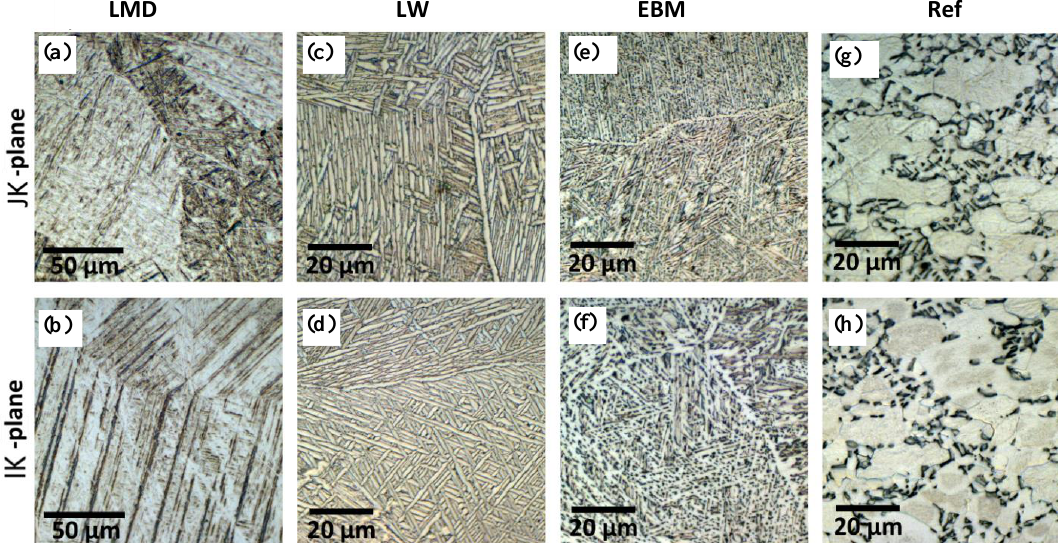
Figure 7. Microstructures of the three AM Ti-6Al-4V alloys and the forged reference. Images of LMD, LW, EBM, and reference materials were taken in the JK- ( a , c , e , g ) and IK-planes ( b , d , f , h ). Note that ( a , c ) are perpendicular to the build direction, and ( b , d , e , f ) are within the built plane.